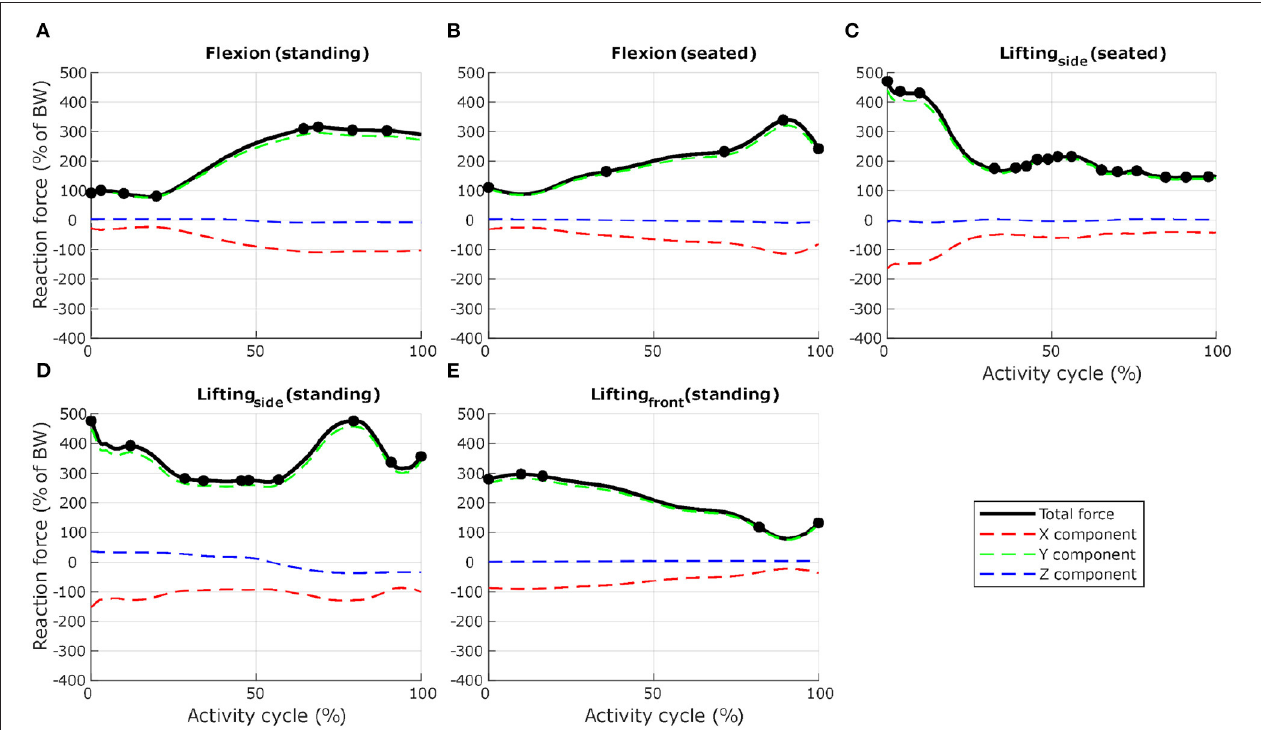
FIGURE 4 | Selection of load cases for L4, for seven activities involving spine movements ( (A) forward flexion from upright standing to maximum flexion, (B) forward flexion from upright sitting, (C) in a seated position, twisting and lifting a box from the floor, from the right side to a table in front, (D) in a standing position, twisting and lifting a box from the floor, from the left side to the right side, and (E) in a standing position, lifting a box from the floor in front to the chest). Total reaction force at L4–L5 joint derived from the musculoskeletal model and normalised to body weight (BW) are shown as black lines. Dots indicate the frames selected for the finite element analysis. Load cases obtained with activities (C,D) were mirrored through the sagittal plane to obtain loading on the other side. Red, green, and blue dashed lines show X, Y, and Z components of the reaction force expressed in the vertebra coordinate